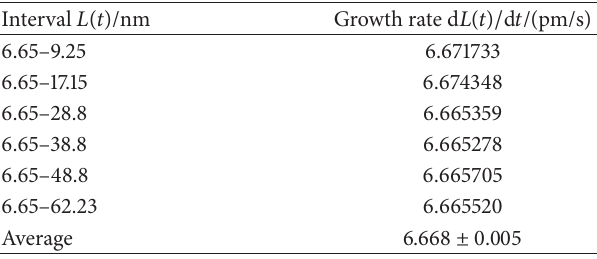
Table 4: Oxide growth rate d 𝐿(𝑡)/ d 𝑡 calculated for distinct oxide thickness intervals for Blanc’s data set A8 (Figure 3). All rate values are calculated at 𝐿 = 6.65 nm.